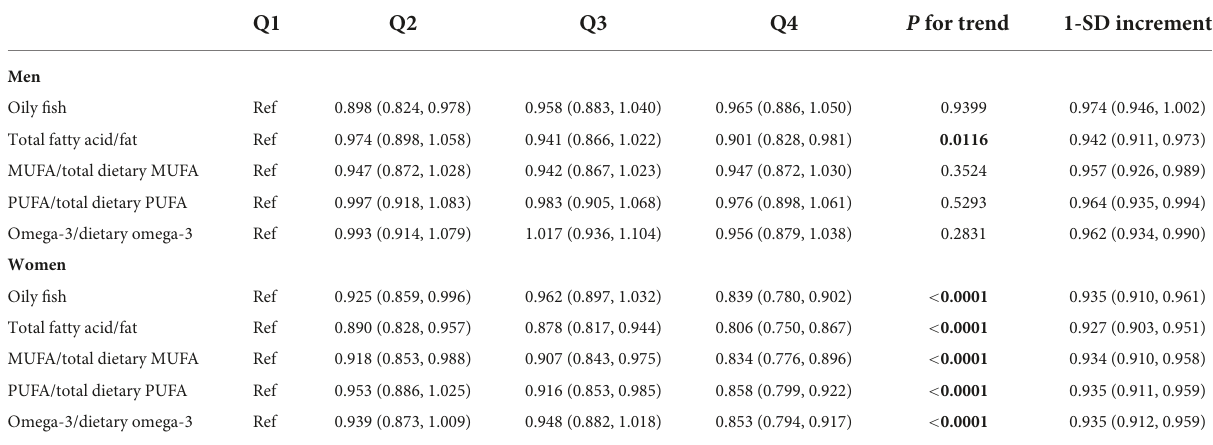
TABLE 2 Hazard ratios (HRs) for fatty liver index – non-alcoholic fatty liver disease (FLI-NAFLD) according to the quartiles of oily fish and its fatty acid